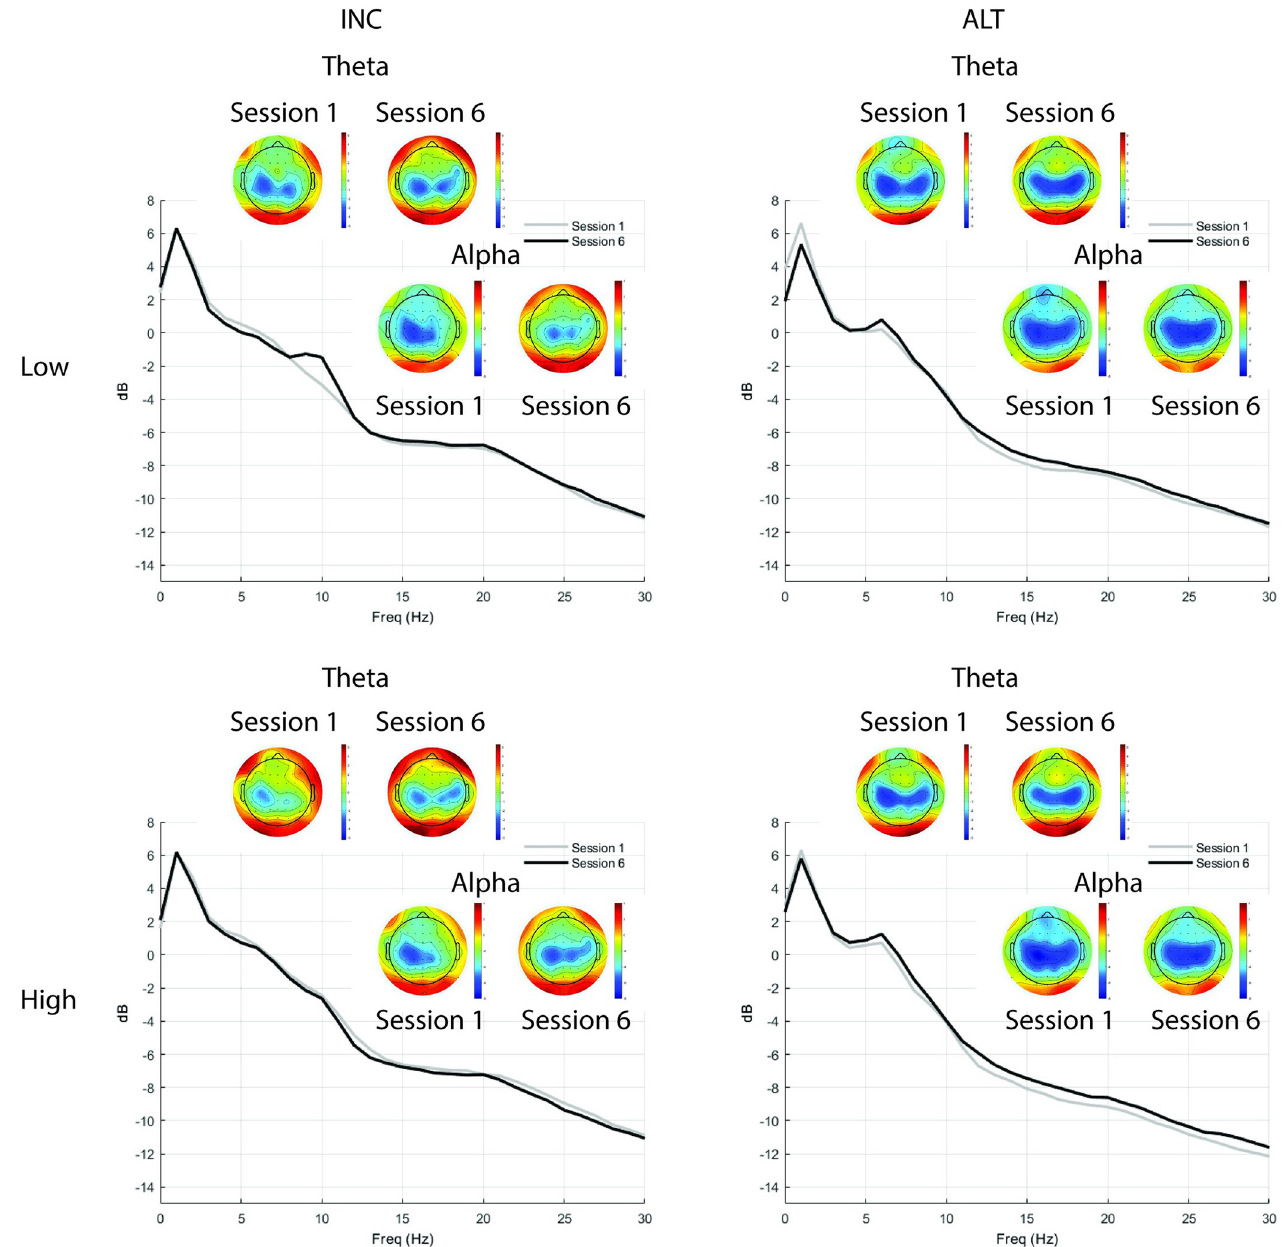
Fig 7. FCz full spectrum and topographic maps of theta and alpha power for the first and last testing sessions for each group during SH. Topographic maps of mean theta (4–7 Hz; top row) and alpha (8–13 Hz; bottom row) power averaged over Blocks for Session 1 (left map) and Session 6 (right map) during SH task and corresponding mean power spectra at FCz from 0–30 Hz for INC group (column 1) and ALT group (column 2) in Low (row 1) and High (row 2) time stress conditions. https://doi.org/10.1371/journal.pone.0283418.g007 effects pseudo R 2 = 0.28, ICC = 74%. The level 2 model accounted for a greater portion of vari- ability than the level 1 model, AIC = 3406.99, BIC = 3437.53, fixed effects pseudo R 2 = 0.28, ICC = 79%. A full model was conducted, the Condition as well as the interactions of Session x Condition, Group x Condition, and Group x Session x Condition were statistically significant. AIC indicated better model fit but BIC did not, AIC = 3385.99, BIC = 3431.80, fixed effects